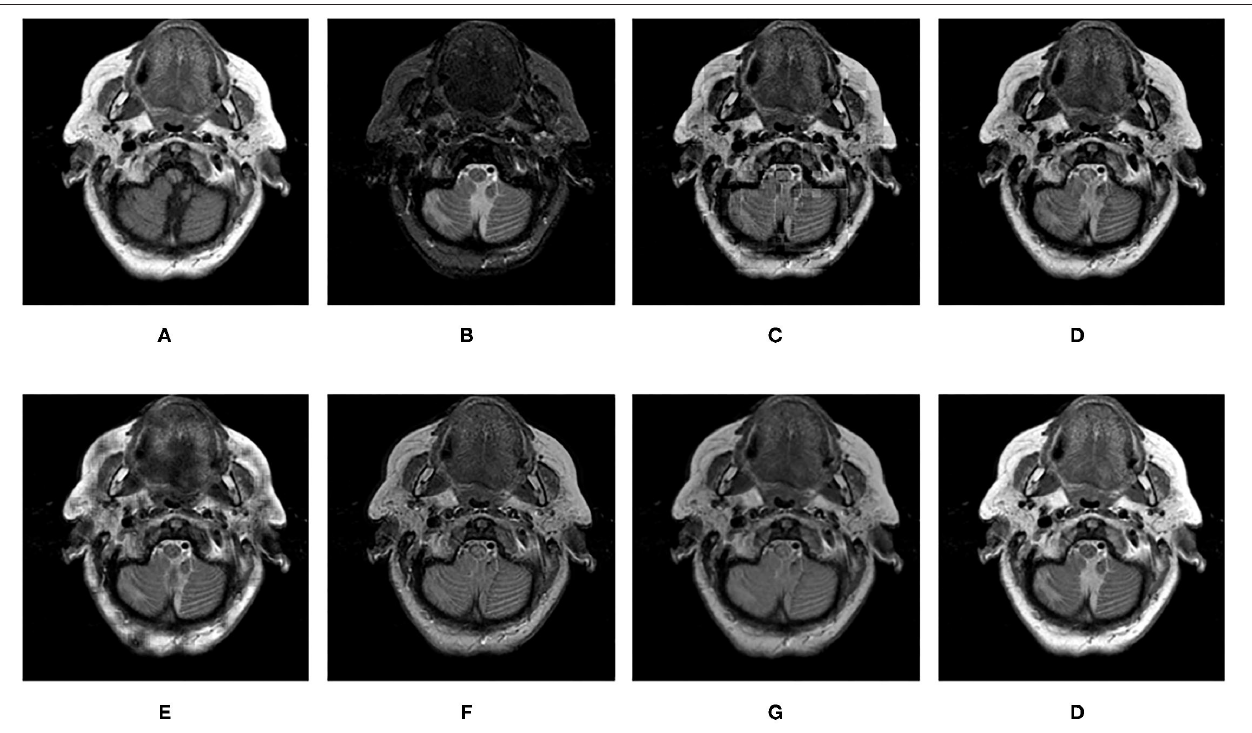
FIGURE 12 | Comparison experimental results of CT and MRI images. (A) original image (CT); (B) original image (MRI); (C) DWT; (D) LP; (E) SR; (F) DTCWT-SR; (G) VGG; (H) MPS.